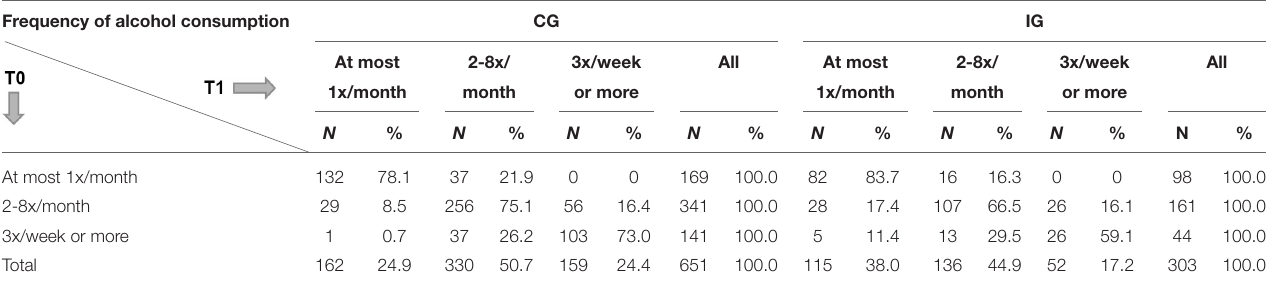
TABLE 7 | Frequency of alcohol consumption at baseline and follow-up among individuals overestimating peer use at baseline and follow-up (CG: n = 651, IG: n =